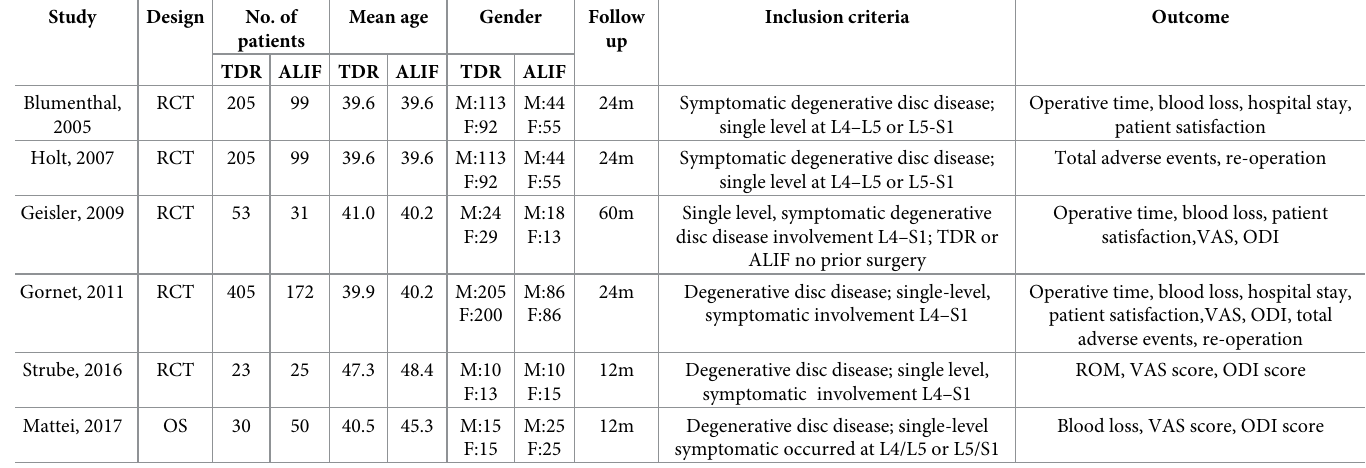
Table 1. Summary of characteristic of included